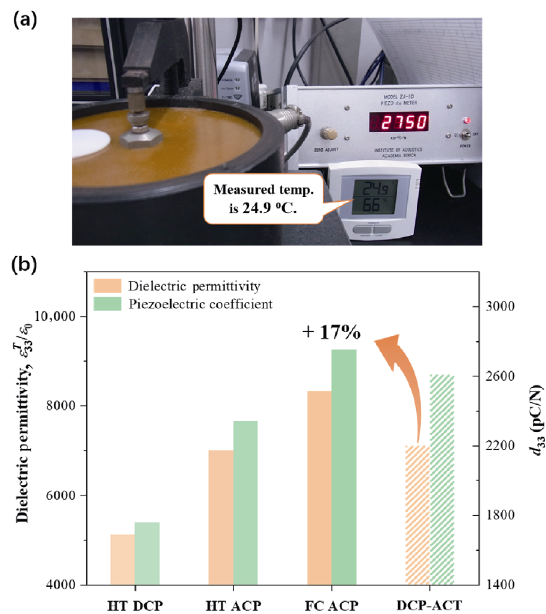
Fig. 2 (a) Real measured value of the ultrahigh d 33 and (b) comparison of / T   and d 33 among HT DCP, HT 33 0